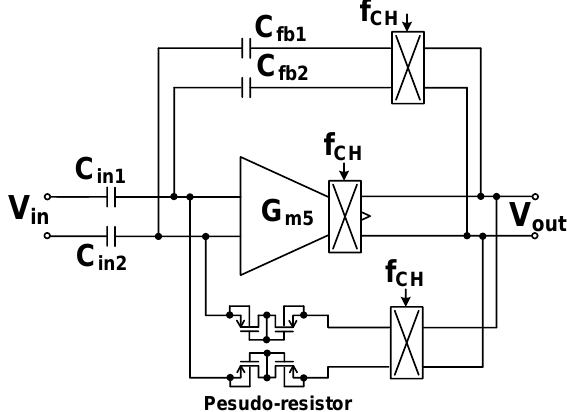
Figure 13. Schematic of the instrumentation amplifier.